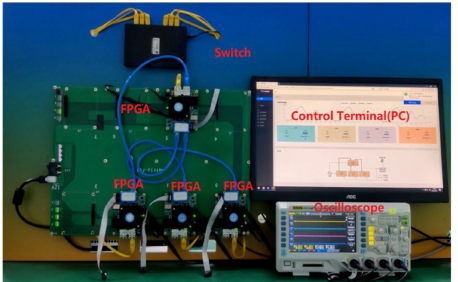
Figure 6. An experiment environment with 4 nodes